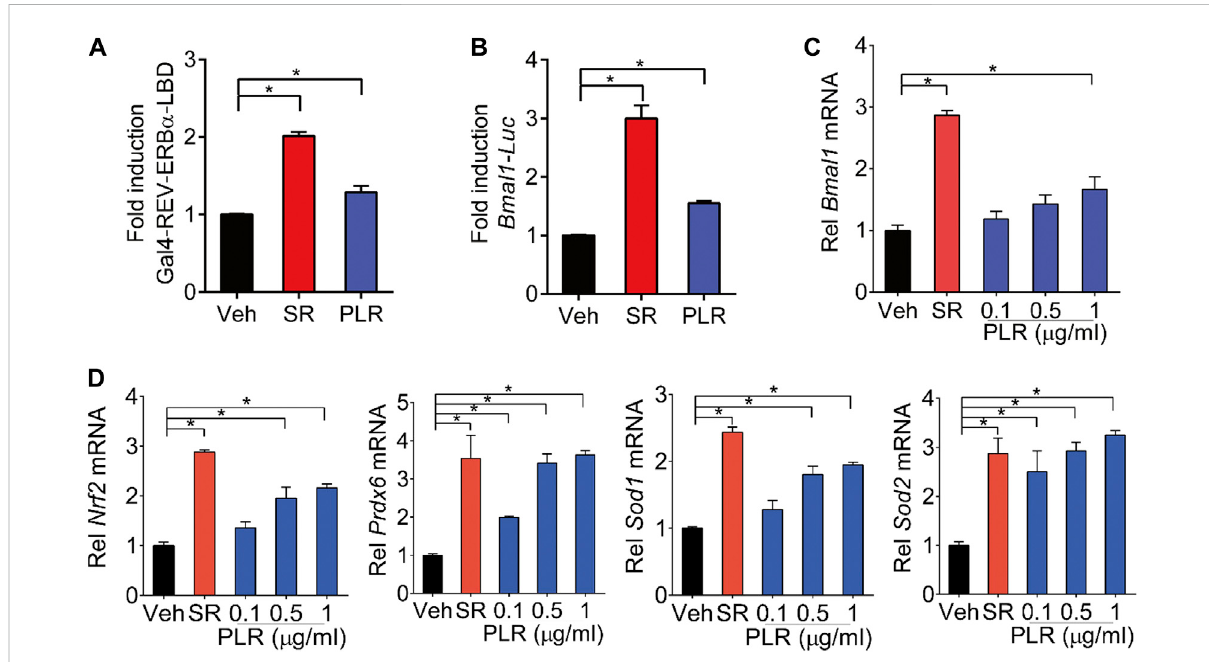
FIGURE 7 Identi fi cation of PLR as an antagonist of REV-ERB α . (A) SR8278 and PLR increase cellular luciferase activities in the Gal4-REV-ERB α -LBD chimeric assays. (B) Effects of PLR on Bmal1-Luc reporter activity in L929 cells. (C,D) mRNA levels of Bmal1 and its target genes in L929 cells. Cells were treated with SR8278 (10 μ M) or different concentrations of PLR as indicated for 24 h. Data are presented as mean ± SD ( n = 3). * p < 0.05. Veh, vehicle; SR,